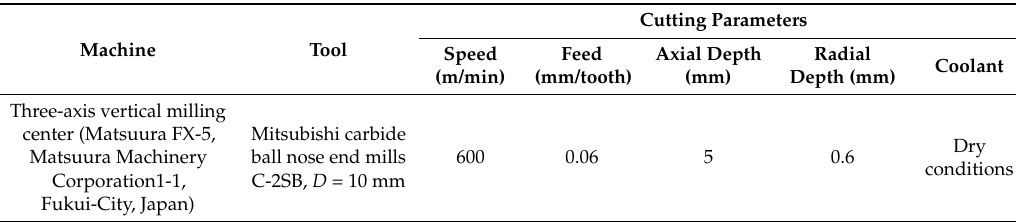
Table 1. Cutting parameters used for the tool-life